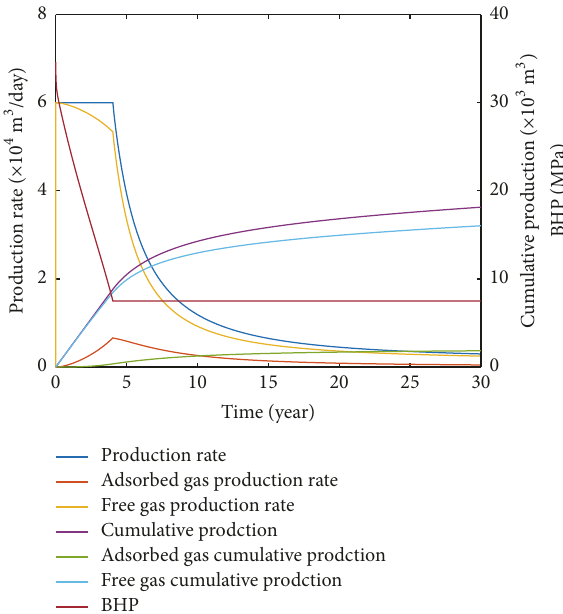
Figure 3: The production rate and cumulative production of base